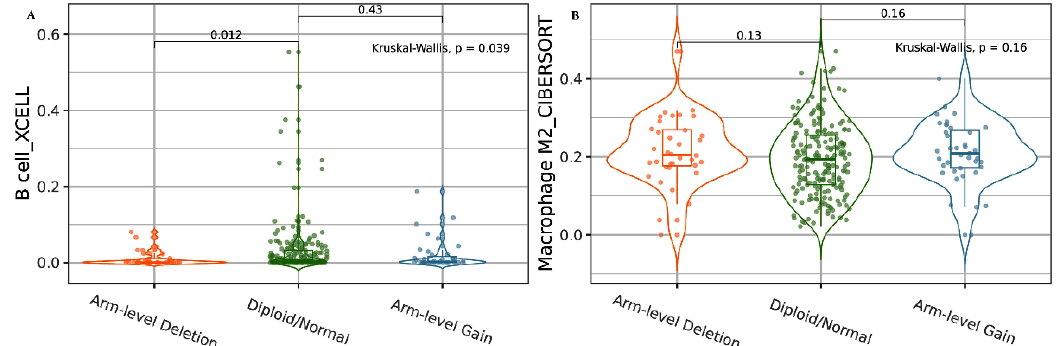
Figure 2. HDAC2 CNAs in B cells and macrophage immune infiltrates. ( A ) Violin plot showing the association between HDAC2 deep deletion and lower levels of B-cell alteration. ( B ) Violin plot showing the association between HDAC2 deep deletion and higher levels of M2 macrophage alteration. Data are shown in Log2 scale (fold change): higher level in mutants = p < 0.05, Log2FC > 0; lower level in mutants = p < 0.05, Log2FC < 0; not significant = p > 0.05.